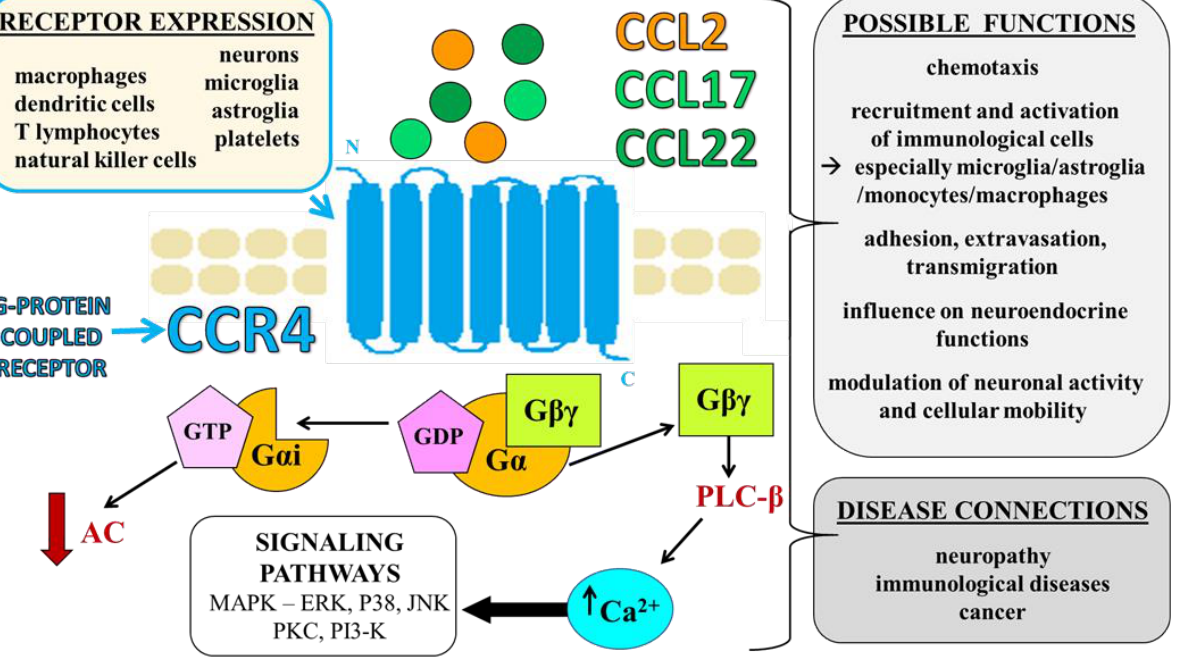
Figure 2. CCR4—mechanisms of action, possible roles, cellular expression, and disease connections. Abbreviations: chemokine receptor 4—CCR4; chemokine (C-C motif) ligand 22 (CCL2); chemokine (C-C motif) ligand 17 (CCL17); chemokine (C-C motif) ligand 22 (CCL22).